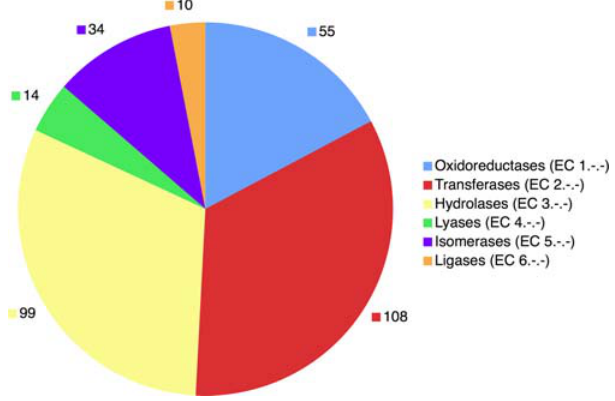
Figure 6. EC Classes of ETA Predictions. Distribution of 320 reciprocal ETA annotations among the first digit EC classes, including both first and second order predictions.